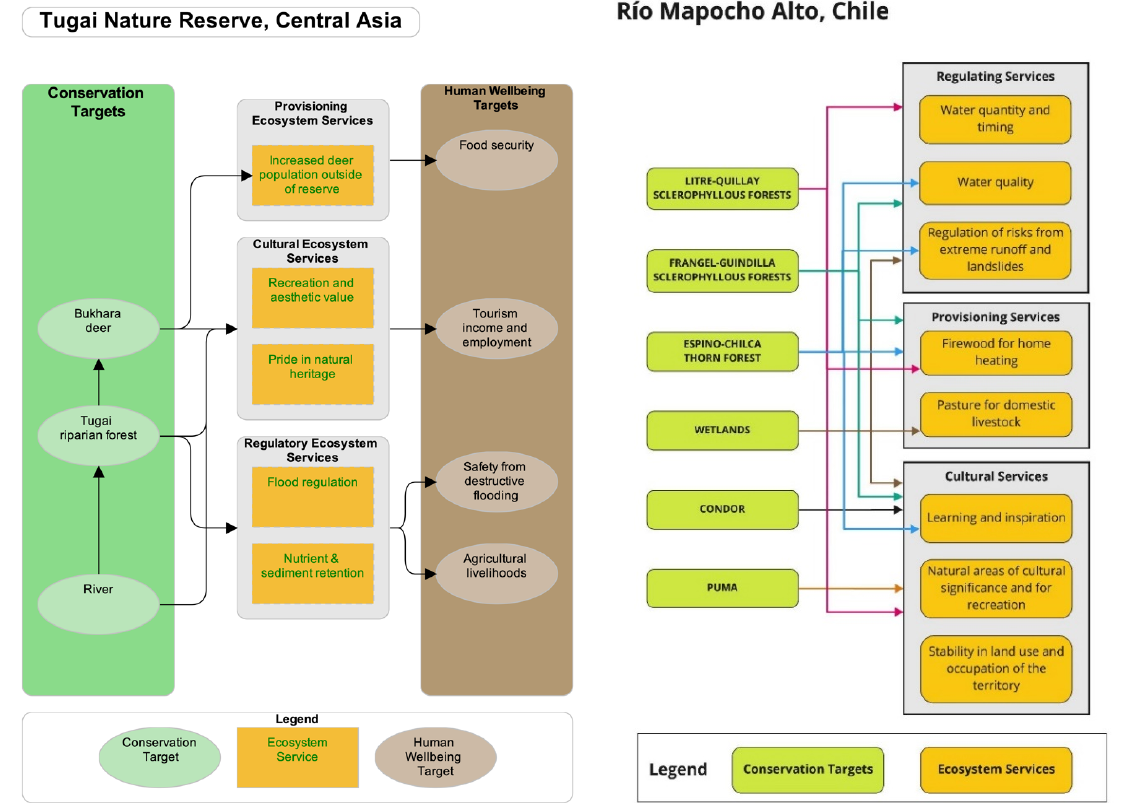
Figure 2. Conservation Targets, Ecosystem Services and Human Well-Being Targets for the Tugai Nature Reserve in Central Asia (adapted with permission from ref. [25]) ( left ) and the Río Mapocho Alto watershed in Chile ( right ).